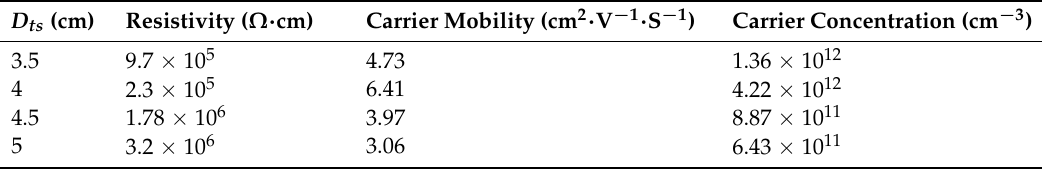
Figure 9. Electrical properties of CdTe films prepared at various substrate-target distances. ( a ) Resistivity; ( b ) carrier mobility. Table 4. Specific electrical parameters of CdTe films.